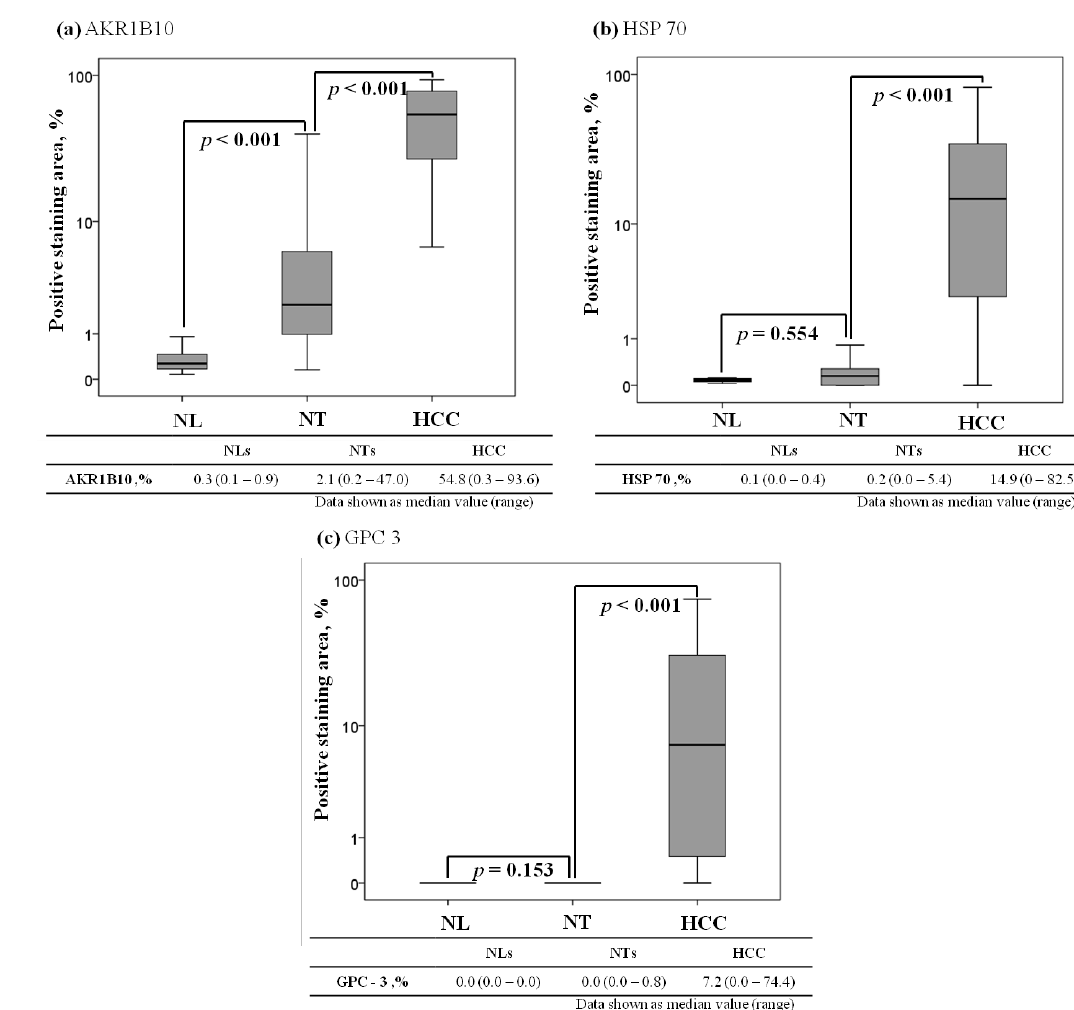
Figure 2. Comparison of AKR1B10, HSP70, and GPC3 expression levels among control normal liver tissues (NLs), non-tumorous liver tissues (NTs), and hepatocellular carcinomas (HCCs). The box encompasses the 25th through 75th percentiles, and the horizontal line through the middle of the box indicates the fiftieth percentile (median). The 10th and 90th percentiles are shown as whisker caps. ( a ) AKR1B10 expression; ( b ) HSP70 expression; and ( c ) GPC3